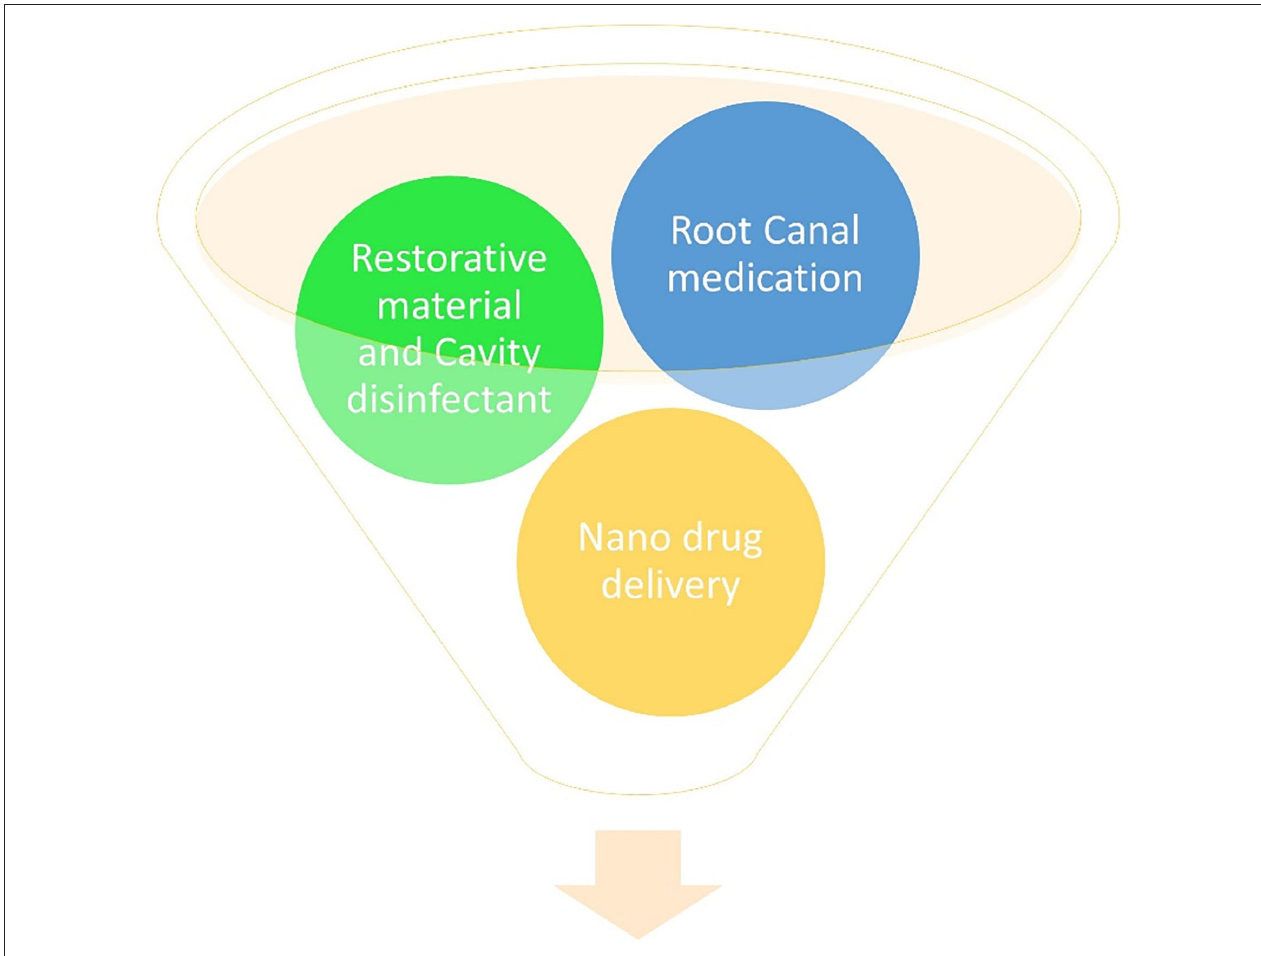
FIGURE 4 | Application of QAS as a restorative material, cavity disinfectant, root canal medicament, and nano-drug